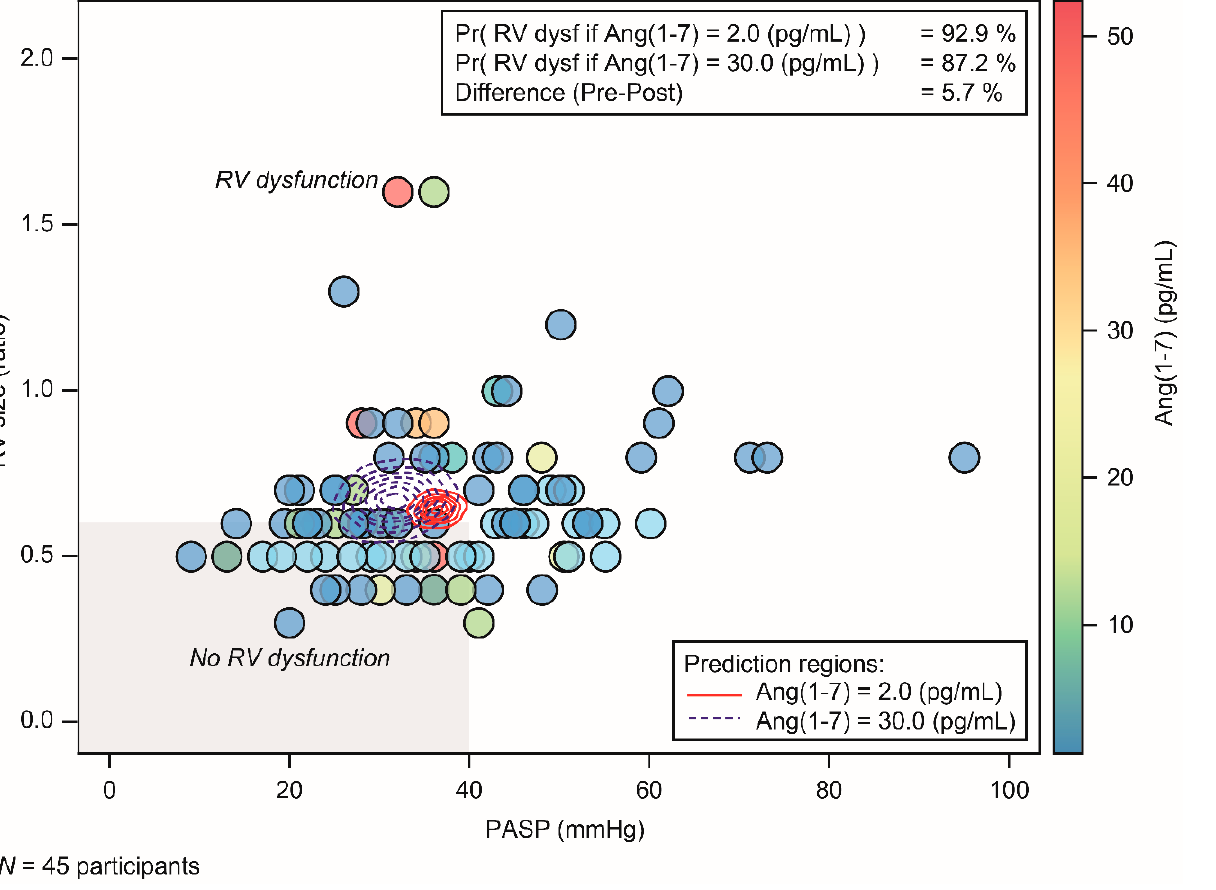
Table 2. Summary of PCD and ARDS incidence rates.